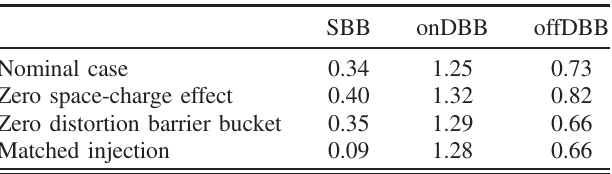
TABLE IV. Final emittance growths in the SBB, onDBB, and